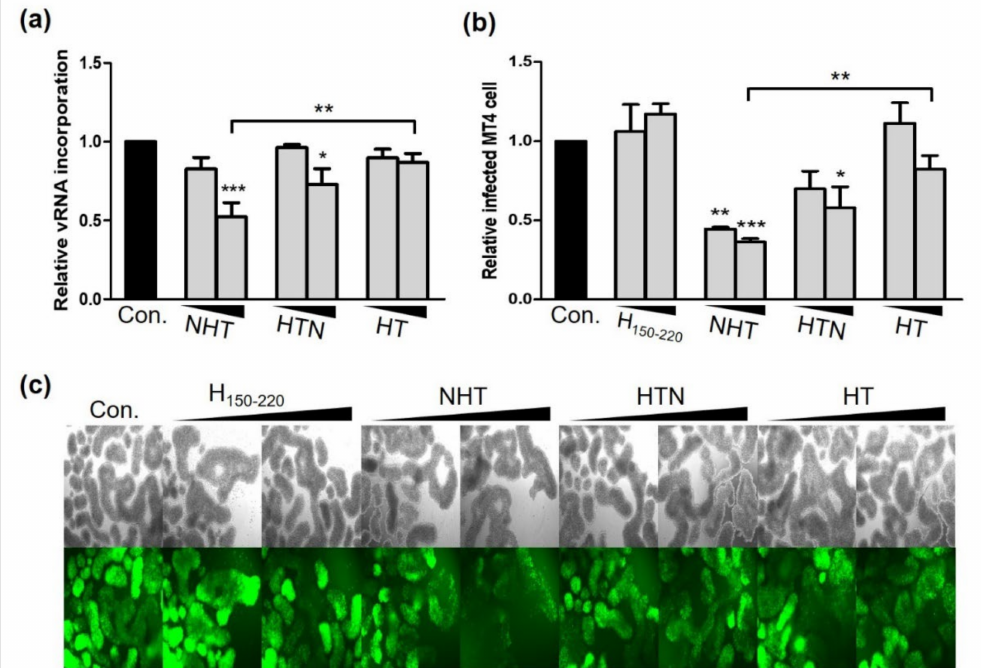
Figure 6. NHT and HTN interrupted vRNA packaging and restrained the infectivity of the progeny virus. ( a ) The amount of vRNA incorporated into the released virus particles was measured by RT-PCR. ( b , c ) The viral supernatant harvested from transfected HEK293T cells was used to transduce 1.4 × 10 5 MT4 cells. MT4 cells were infected with viral supernatant containing the same amount of p24 particles as quantified by ELISA. Detection of GFP-positive infected cells by FACS ( b ) and fluorescence microscopy ( c ). All the microscopy images were at 100 × magnification. Statistical significance was assessed using one-way ANOVA (* p < 0.05, ** p < 0.01, *** p <